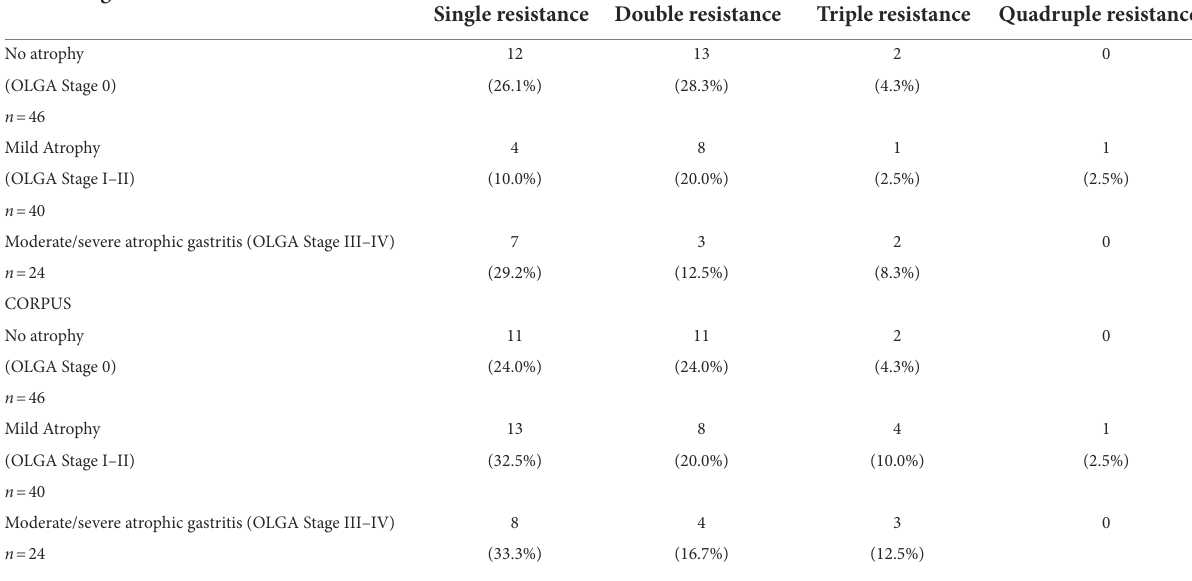
TABLE 1 Single, double, triple and quadruple resistance in antrum and corpus, according to the severity of atrophy.